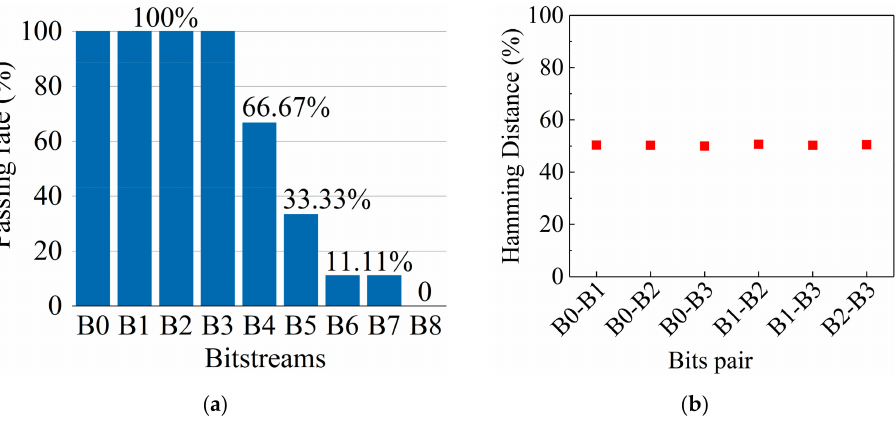
Figure 8. ( a ) NIST tests passing rate for the nine generated bitstreams. ( b ) Hamming distances among the bitstreams passing the NIST tests